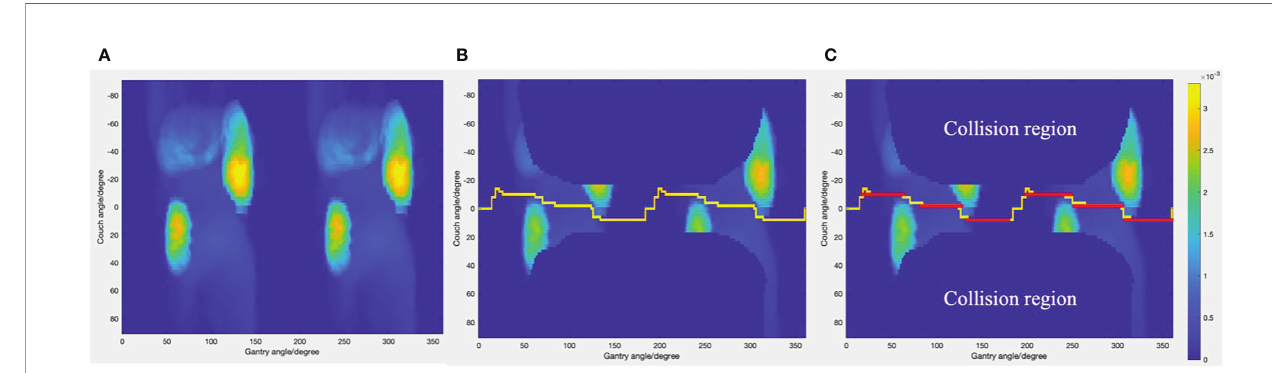
FIGURE 1 | (A) Cost map generated through ray-tracing simulation. (B) The least cost trajectory generated by Dijkstra ’ s algorithm displayed on cost map with collision region excluded. (C) The subarcs with fi xed couch positions (displayed as red lines) adopted as fi nal